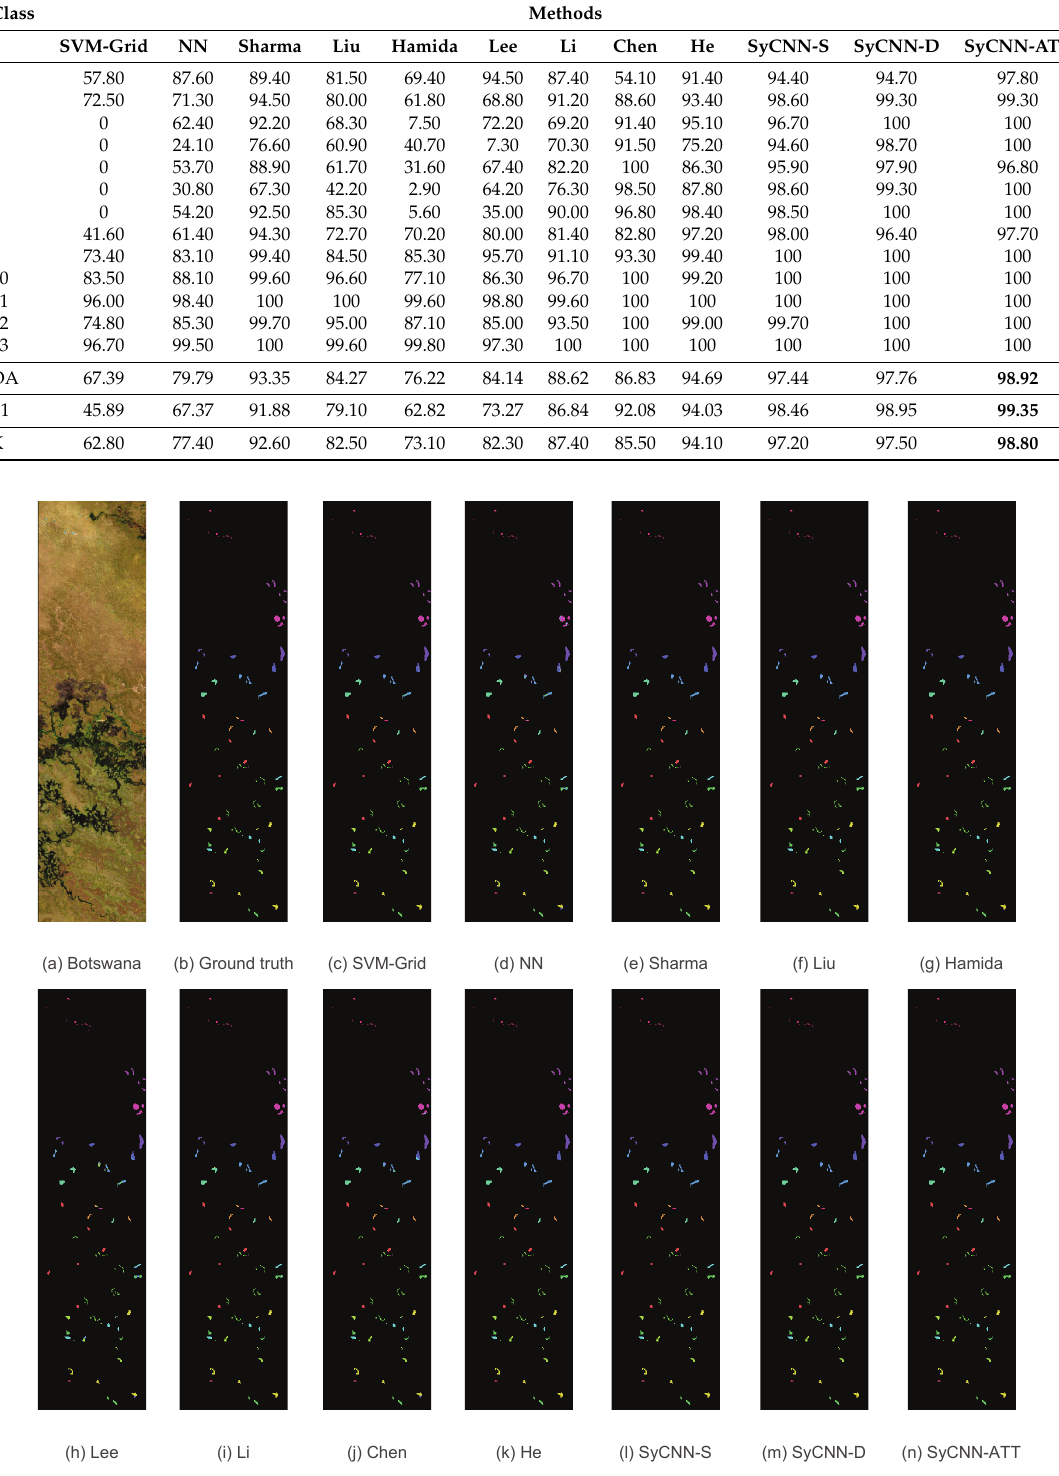
Figure 9. Visualization of the experimental results based on Botswana: ( a ) Indian Pines, ( b ) Ground truth, ( c ) SVM-Grid, ( d ) NN, ( e ) Sharma, ( f ) Liu, ( g ) Hamida, ( h ) Lee, ( i ) Li, ( j ) Chen, ( k ) He, ( l ) SyCNN-S, ( m ) SyCNN-D, ( n ) SyCNN-ATT. It is observed that the outputs produced by our proposed models are quite close to the Ground